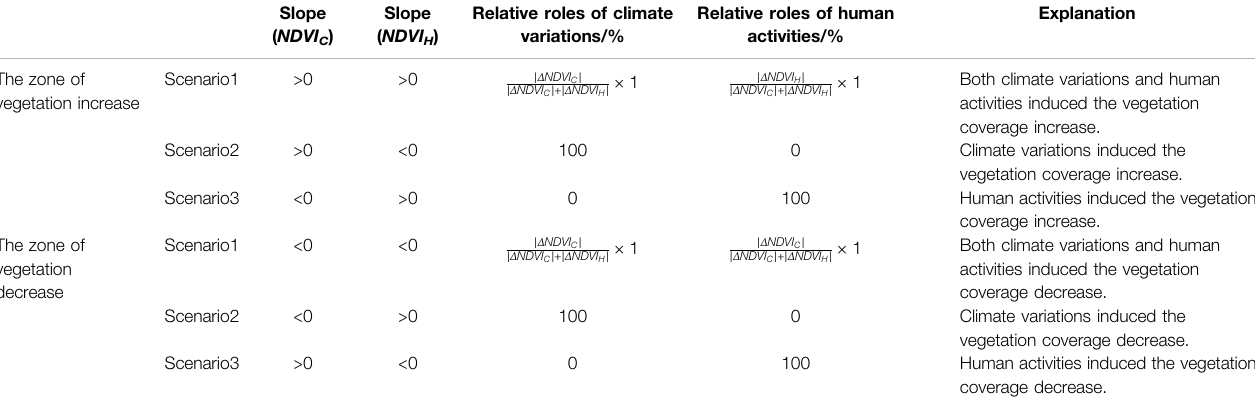
TABLE 1 | Methods for assessing the relative roles of climate change and human activities on vegetation variation.